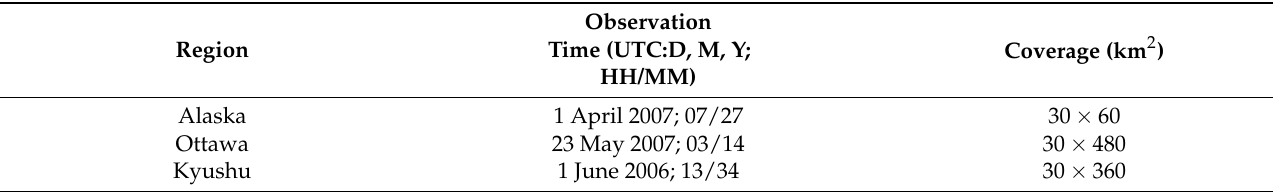
Figure 1. True TEC maps of enhanced FRA arcs in Alaska, USA, covering about 30 × 60 km 2 ( a ); midlatitude ionospheric trough in Ottawa, ON, Canada, covering about 30 × 480 km 2 ( b ); and traveling ionospheric disturbance in Kyushu, Japan, covering about 30 × 360 km 2 ( c ). Table 1. PALSAR data information of Figure